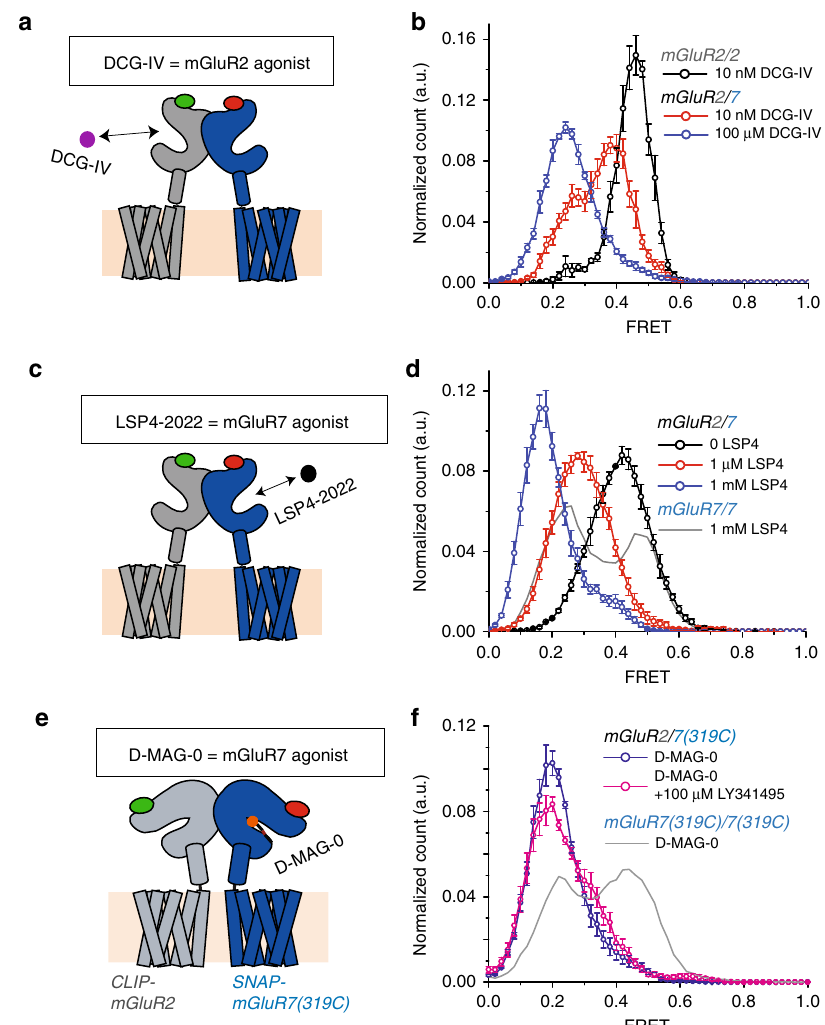
Fig. 5 Enhanced agonism in the mGluR2/7 heterodimer. Single subunit agonism in mGluR2/7 drives greater activated state occupancy (lower FRET values) than agonism of both subunits in either mGluR2/2 or mGluR7/7. a Schematic of CLIP-mGluR2/SNAP-mGluR7 binds DCG-IV only in mGluR2. b smFRET histograms of CLIP-mGluR2/SNAP-mGluR7 and SNAP-mGluR2/SNAP-mGluR2 show greater activation at 10nM DCG-IV in mGluR2/7 (red) (6 movies, 189 molecules, s.e.m. error bars) than in mGluR2/2 (black) (4 movies, 119 molecules, s.e.m. error bars). mGluR2/2 in the presence of 100 μ M DCG-IV (blue) (4 movies, 234 molecules, s.e.m. error bars). ( c ) Schematic of CLIP-mGluR2/SNAP-mGluR7 binds LSP4-2022 only in mGluR7. d smFRET histograms of CLIP-mGluR2/SNAP-mGluR7 and SNAP-mGluR7/SNAP-mGluR7 show greater activation at 1 mM LSP4-2022 in mGluR2/7 (red) than mGluR7/7 (gray). CLIP-mGluR2/SNAP-mGluR7 in the presence of 0 (6 movies, 187 molecules, s.e.m. error bars), 1 μ M (6 movies, 175 molecules, s.e.m error bars) and 1 mM (6 movies, 189 molecules, s.e.m. error bars) LSP4. e Schematic of CLIP-mGluR2/SNAP-mGluR7(K319C) with D-MAG-0 attached to K319C docking glutamate into the mGluR7 LBD in the trans con fi guration. f smFRET histograms of CLIP-mGluR2/SNAP-mGluR7(K319C) and SNAP-mGluR7(K319C)/ SNAP-mGluR7(K319C), with trans D-MAG-0 (6 movies, 158 molecules, s.e.m error bars), show greater activation in mGluR2/7 (blue) than mGluR7/7 (gray). 100 µ M of the orthosteric antagonist LY341495 has little effect on activation by D-MAG-0 on mGluR2/7 (magenta) (6 movies, 174 molecules, s.e.m. error bars), in contrast to the complete block seen in mGluR7/7 (Fig. 2c). b , d , f BC-DY-547 (donor) and BG-Alexa-647 (acceptor) imaged at